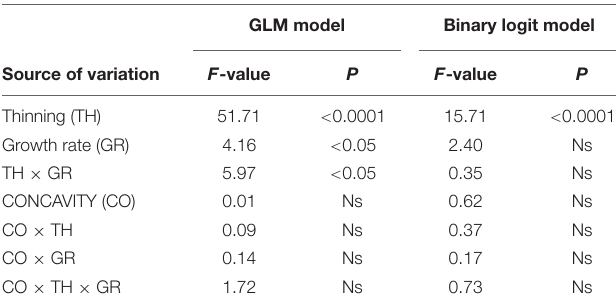
TABLE 1 | Effects of thinning (TH), growth rate (GR), and concavity during the spruce budworm outbreak (CO) on the growth pattern after thinning.